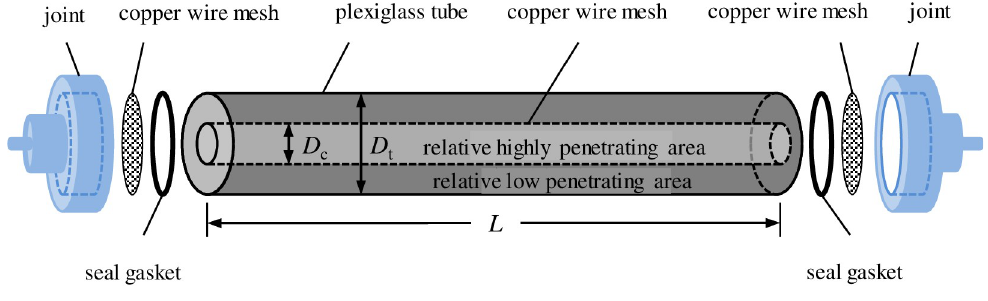
Fig 3. Heterogeneous model of the single pipe.